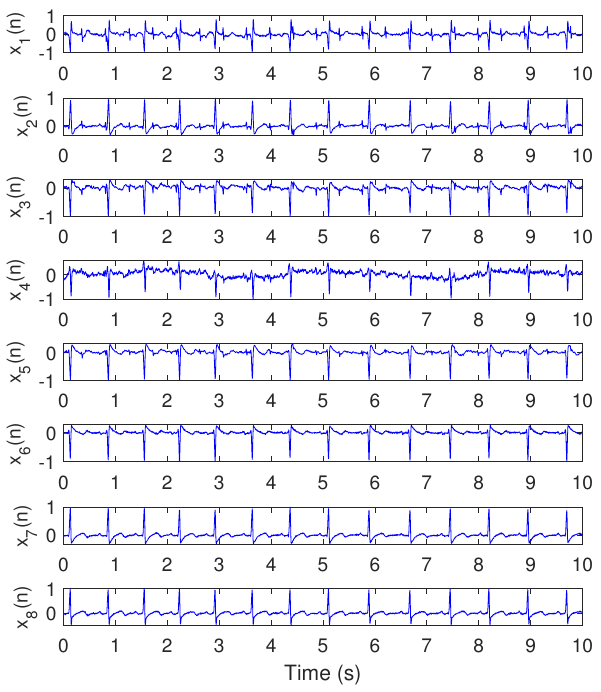
Figure 6. Recorded ECG signals using DAISY data set, N = 2500, M = 8, f s = 250 Hz.The abdominal signals are the first five signals from the top ( x 1 ( n ) – x 5 ( n )) while the remaining three ( x 6 ( n ) – x 8 ( n )) are thorax signals.